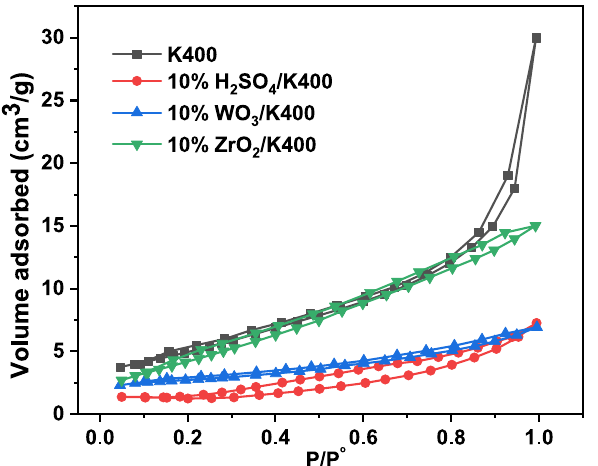
Figure 3. N 2 adsorption–desorption isotherms of kaolin and modified kaolin catalysts calcined at 400